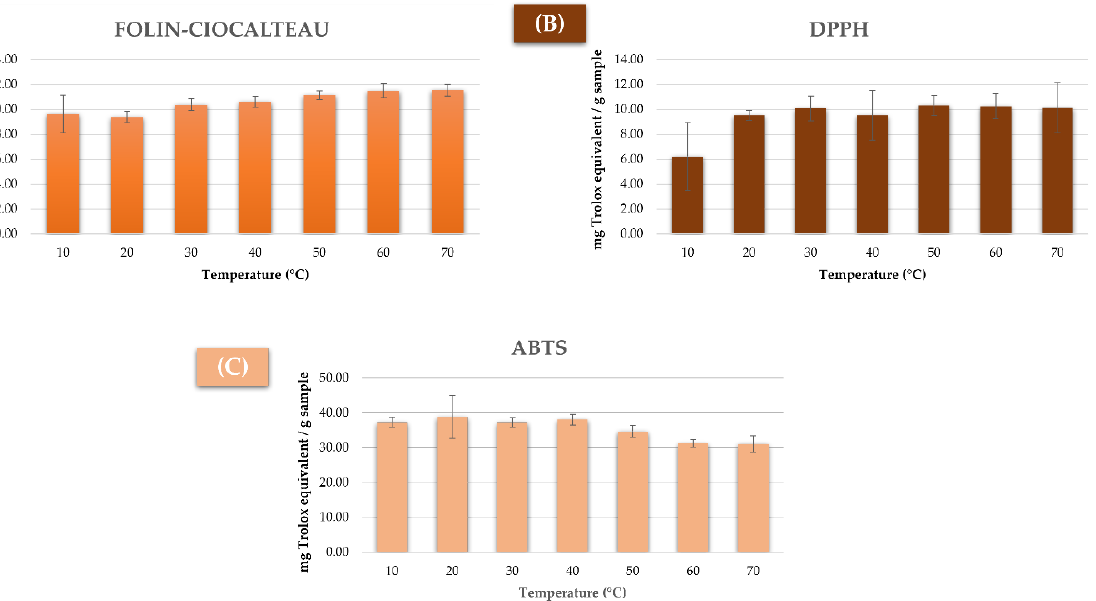
Figure 2. Results from the analysis of mushroom extracted by UAE using different extraction tem- peratures by ( A ) Folin–Ciocalteu method (milligrams of gallic acid equivalent/gram of sample), ( B ) DPPH method (milligrams of Trolox equivalent/gram of sample), and ( C ) ABTS method (milligrams of Trolox equivalent/gram of sample).